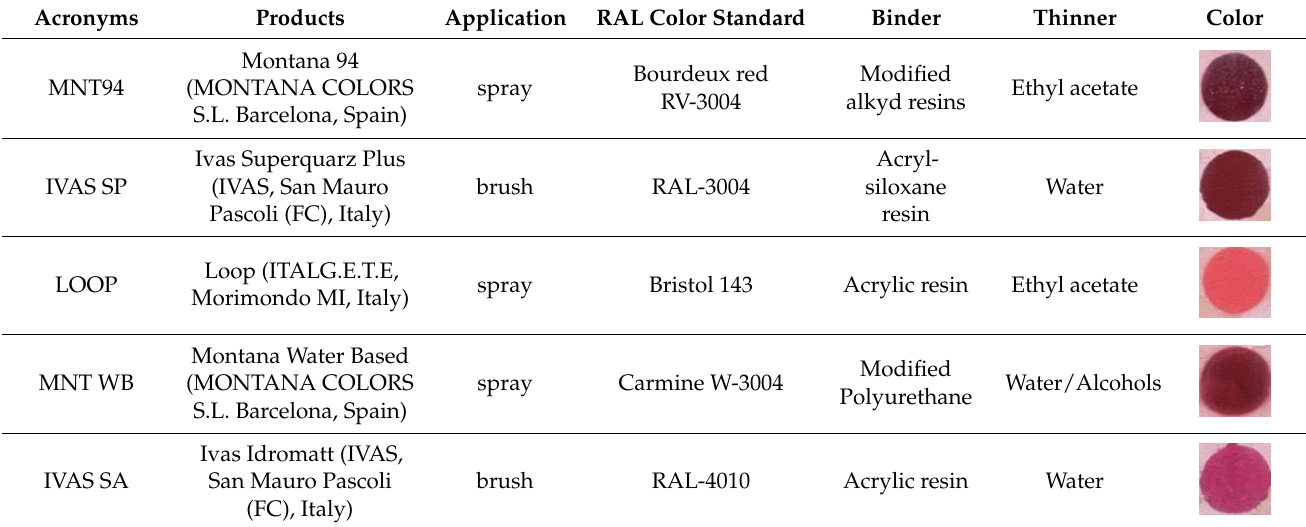
Table 1. List of paints.